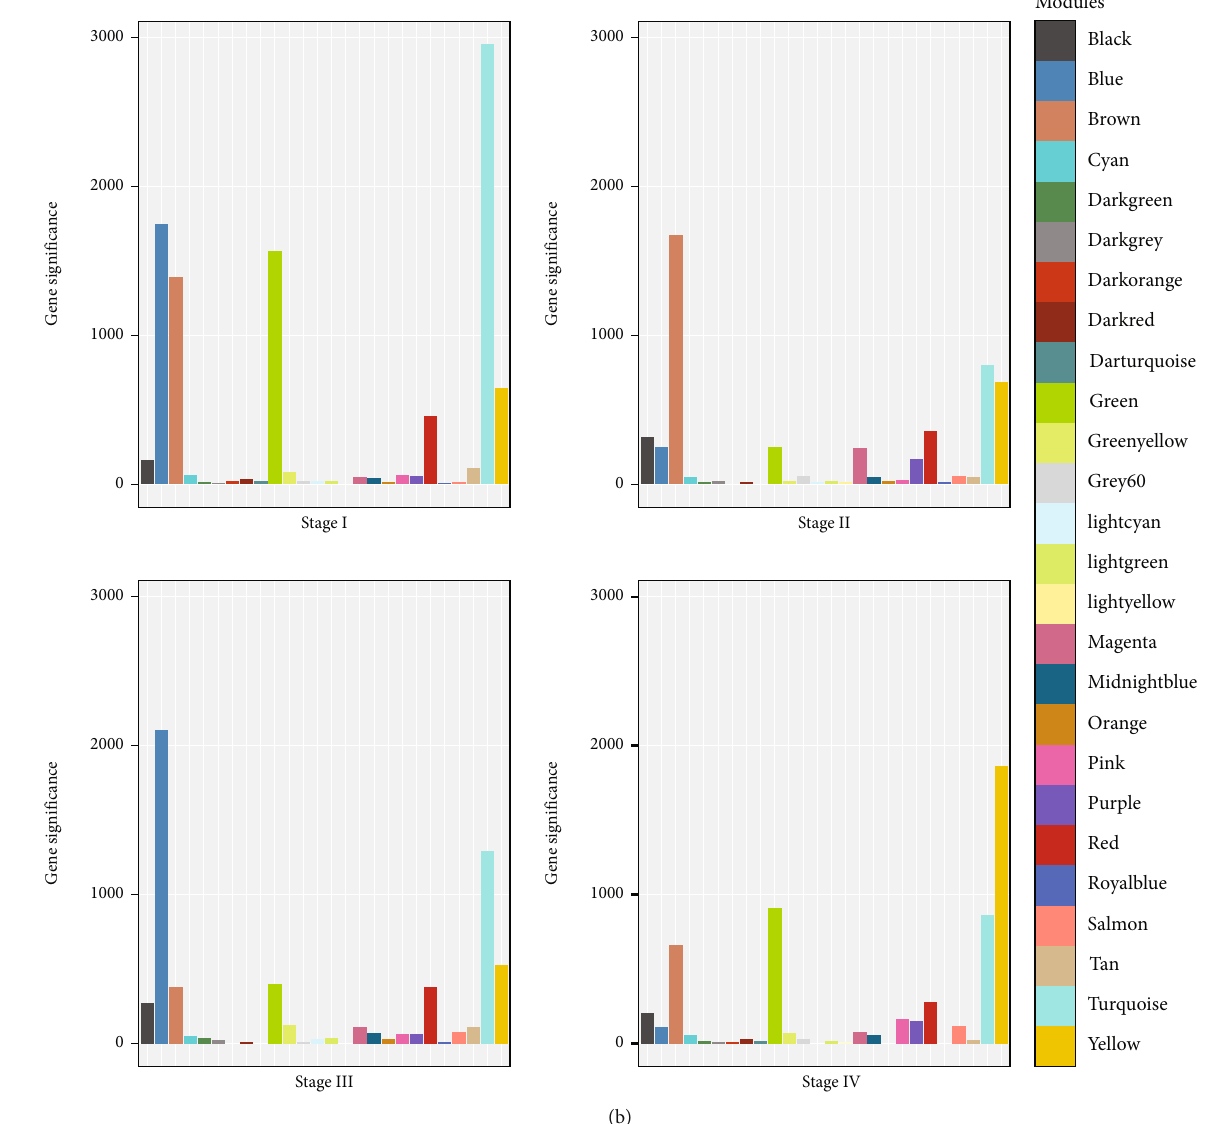
Figure 4: Stage-speci fi c gene modules detected by WGCNA. (a ) Module-trait relationship heatmap. Each row corresponds to a module, and each column corresponds to a stage. The degree of correlation is illustrated with the colour legend. The numbers in the table correspond to the p value. Modules that are signi fi cantly associated with each somatic embryo development stage ( j r j > 0 : 8 and p value ≤ 0.01) are indicated by an asterisk. (b ) Gene signi fi cance values of coexpression modules related to di ff erent somatic embryo developmental